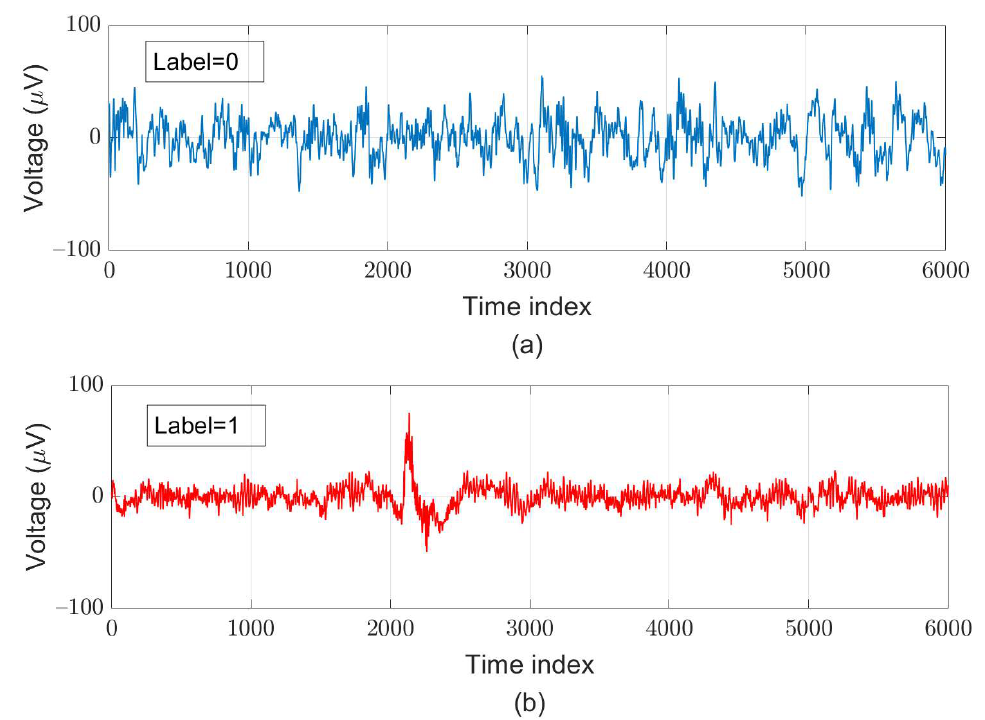
Figure 5. Examples of ( a ) normal (label = 0) and ( b ) arousal (label = 1) segments each with a 30-s length obtained at the C3-M2